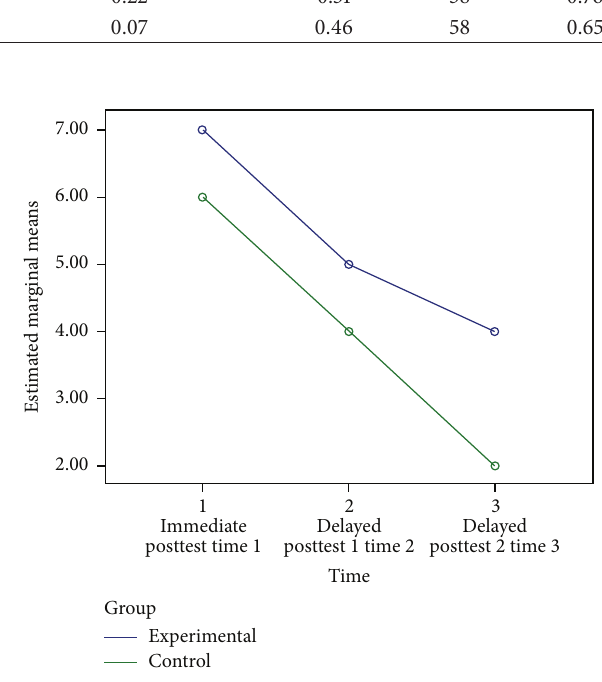
Figure 1: Mean changes of the participants’ scores on receptive vocabulary